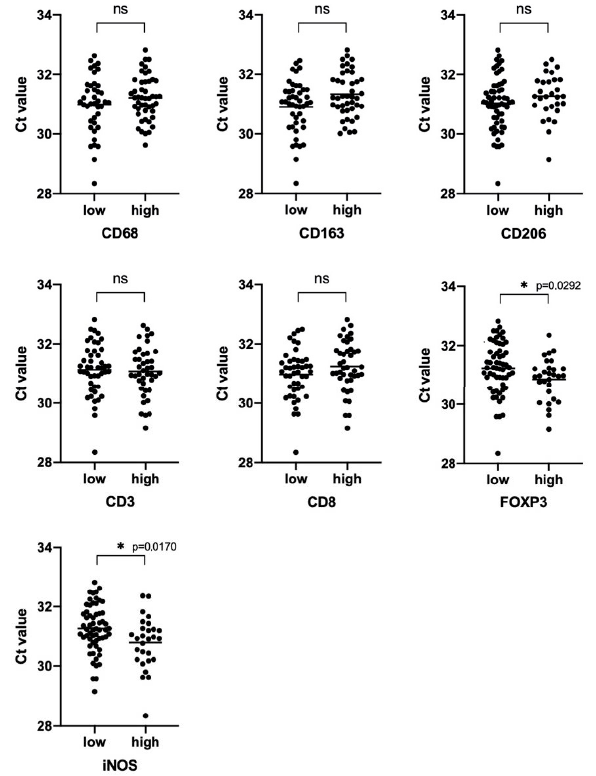
Figure 6. Real-time 16S PCR results as expressed by cycles to the cross threshold (Ct) for samples from ff erent stroma phenotype. p -value evaluated with a U Mann–Whitney test. patients with a different stroma phenotype. p -value evaluated with a U Mann–Whitney test. from patients with a di ( ∗ - statistically